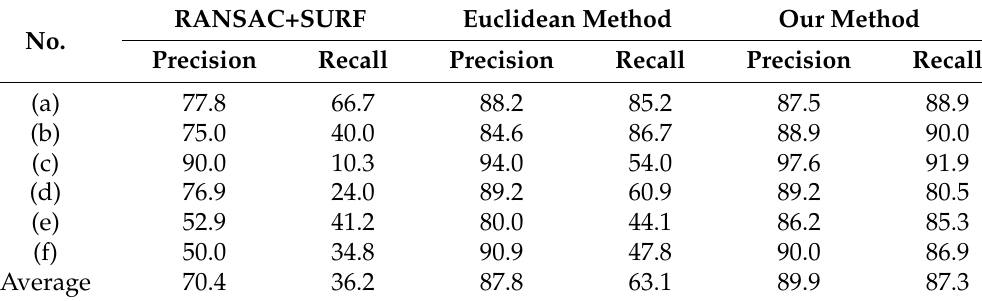
Table 3. Sparse matching results.